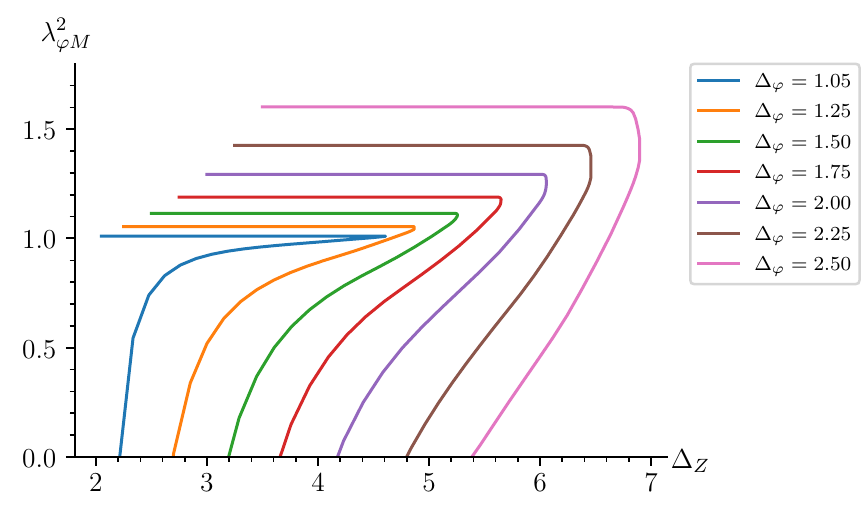
Figure 10 . Upper and lower bounds of the protected operator ϕM that appears in the ϕ × M OPE, as a function of the dimension ∆ Z of the first long in the same channel. We compare the results for different dimensions of the Coulomb branch operator ∆ ϕ . All numerical optimizations are performed at Λ = 24